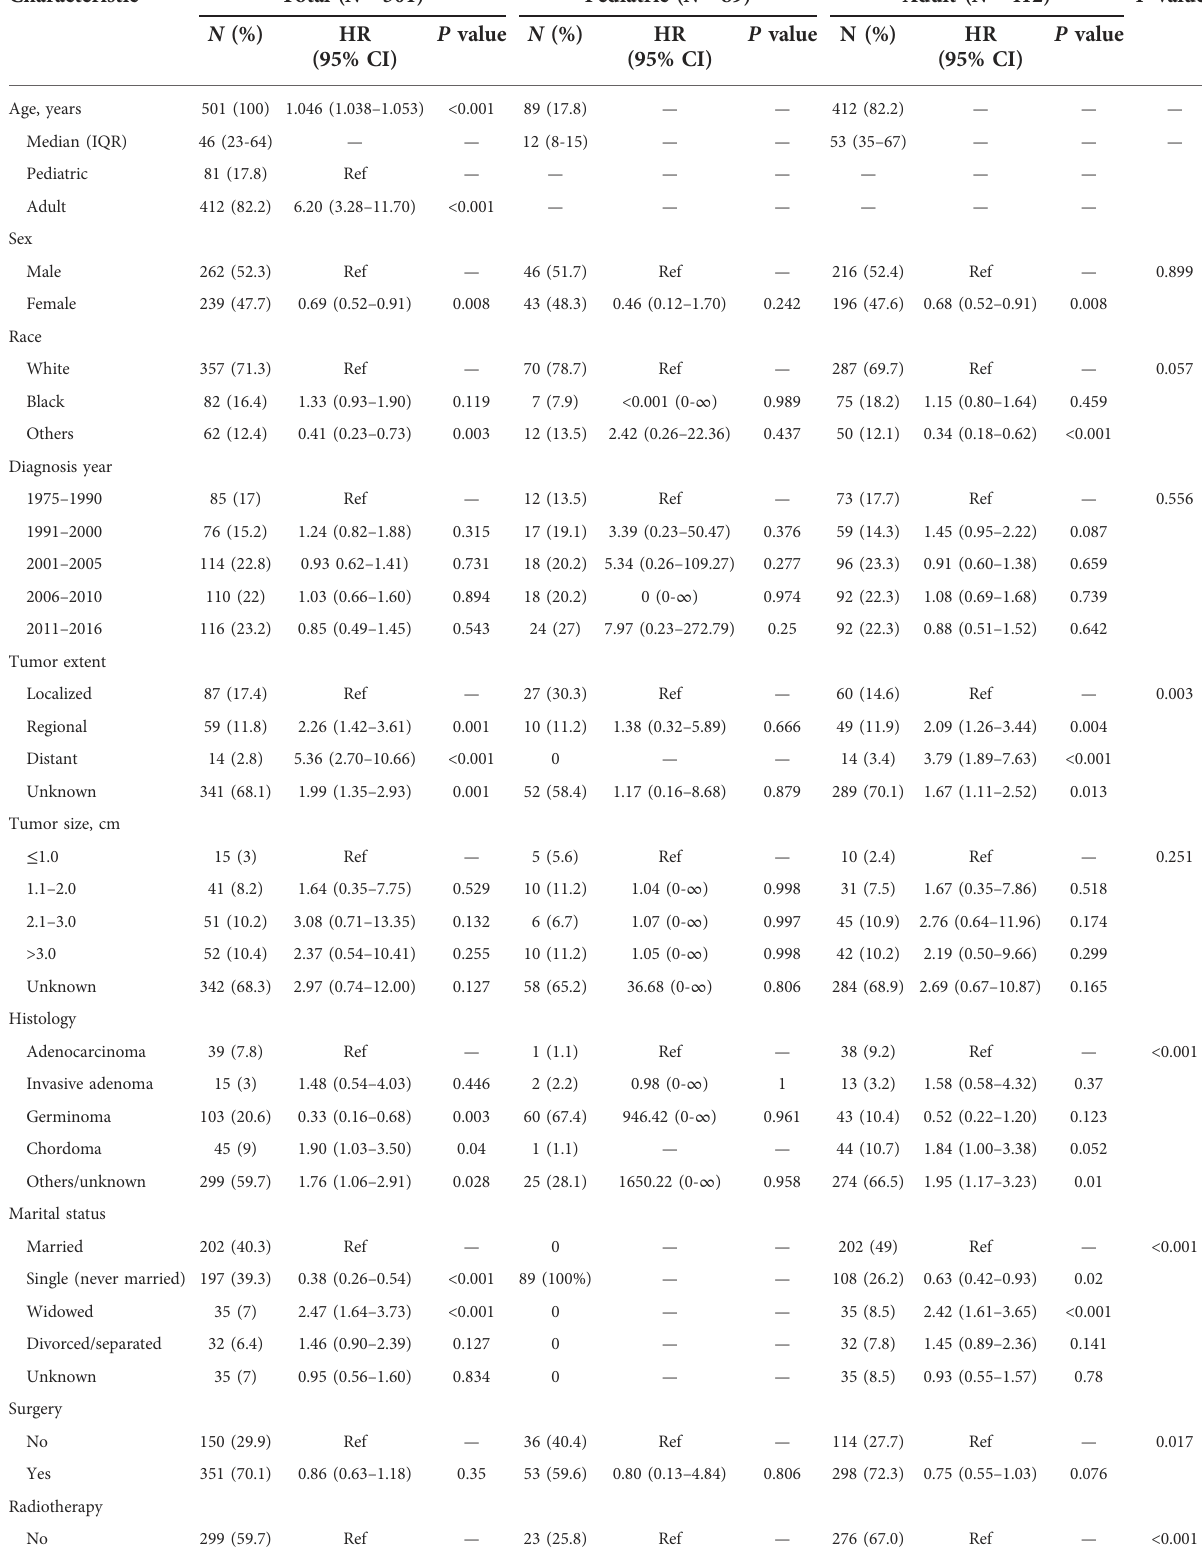
TABLE 1 Univariate Cox regression analyses for overall survival in patients with primary malignant pituitary tumors.